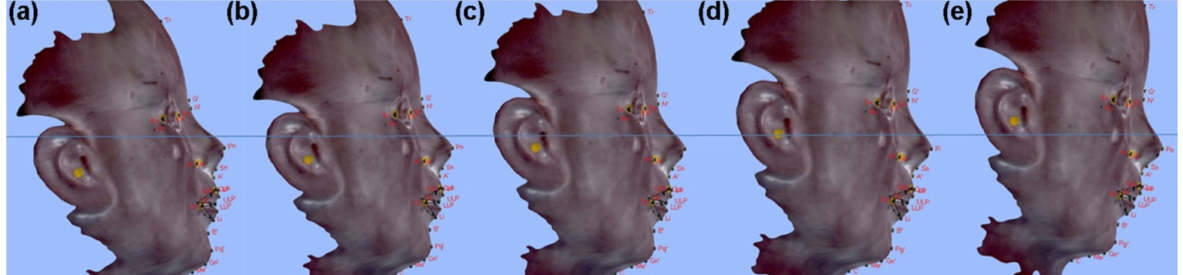
Figure 2. Groups used in this study: ( a ) Group D+10 ◦ ; ( b ) Group D+5 ◦ ; ( c ) Group D − 0 ◦ ; ( d ) Group D − 5 ◦ ; ( e ) Group D − 10 ◦